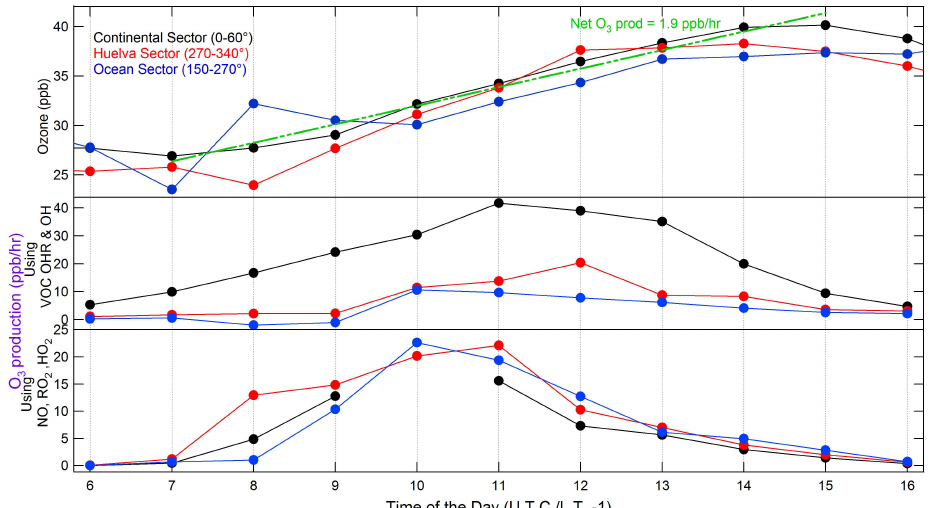
Fig. 6. Diurnal profile of O 3 and the instantaneous rates of O 3 production potential (black: continental sector; red: huelva sector; blue: ocean sector) derived from the in-situ measurements made at Base de Arenosillo, 37 ◦ 05 0 58 00 N, 6 ◦ 44 0 17 00 W.